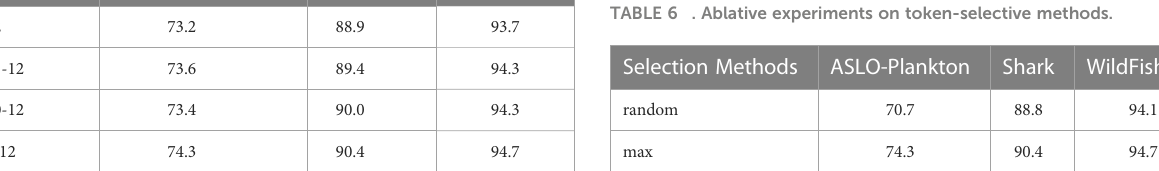
TABLE 4 Ablative experiments on applying TSSA to different deep layers. Layers